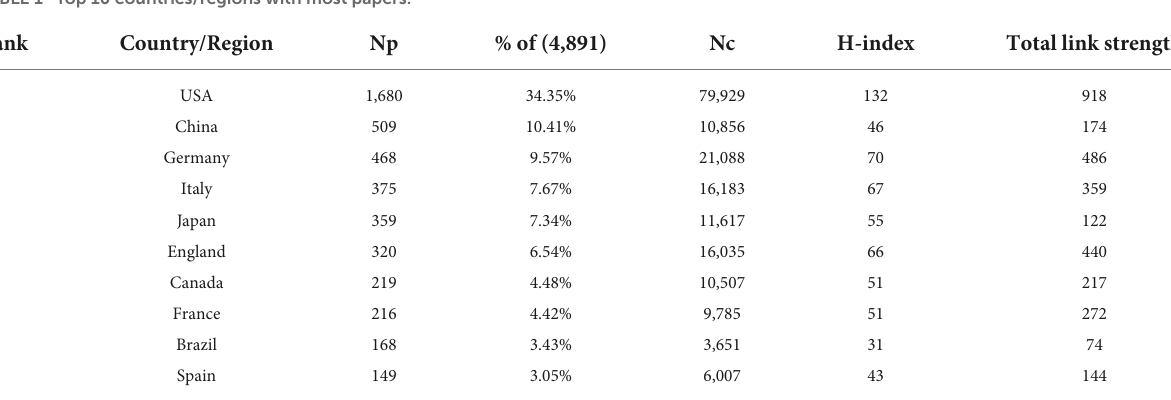
TABLE 1 Top 10 countries/regions with most